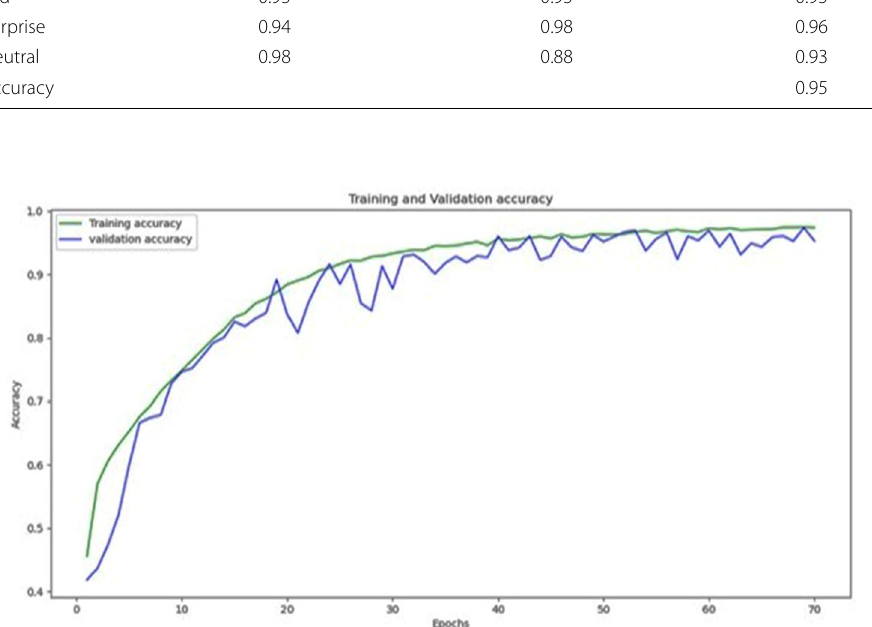
Fig. 4 The accuracy of training and